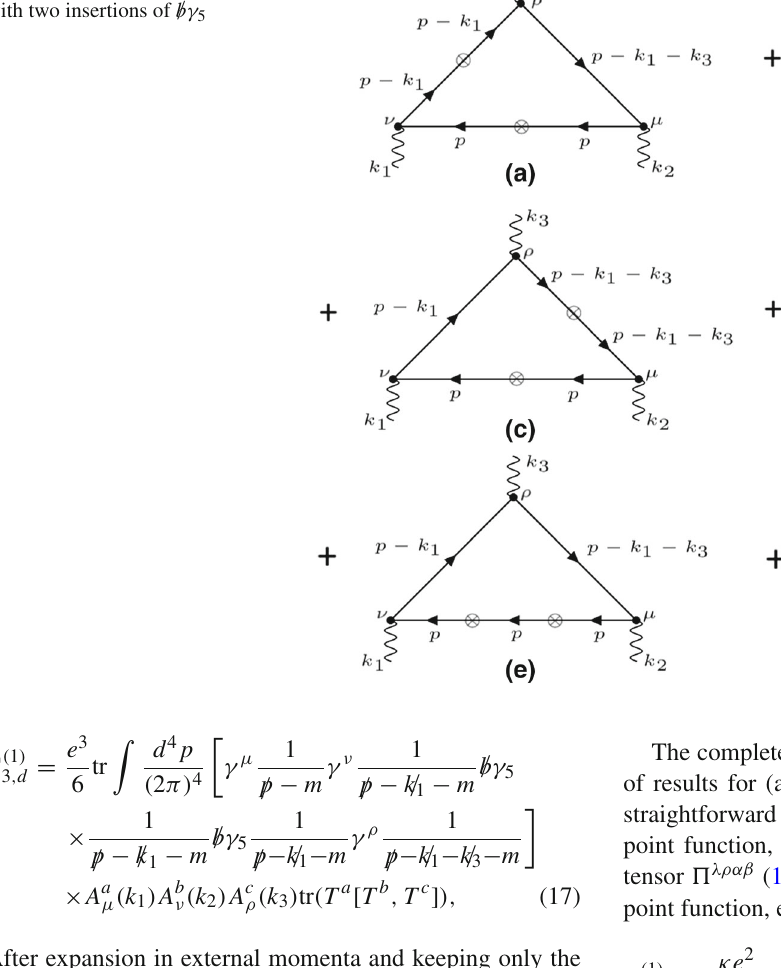
Fig. 1 Contributions of the third order in the external fields, with two insertions of / b γ